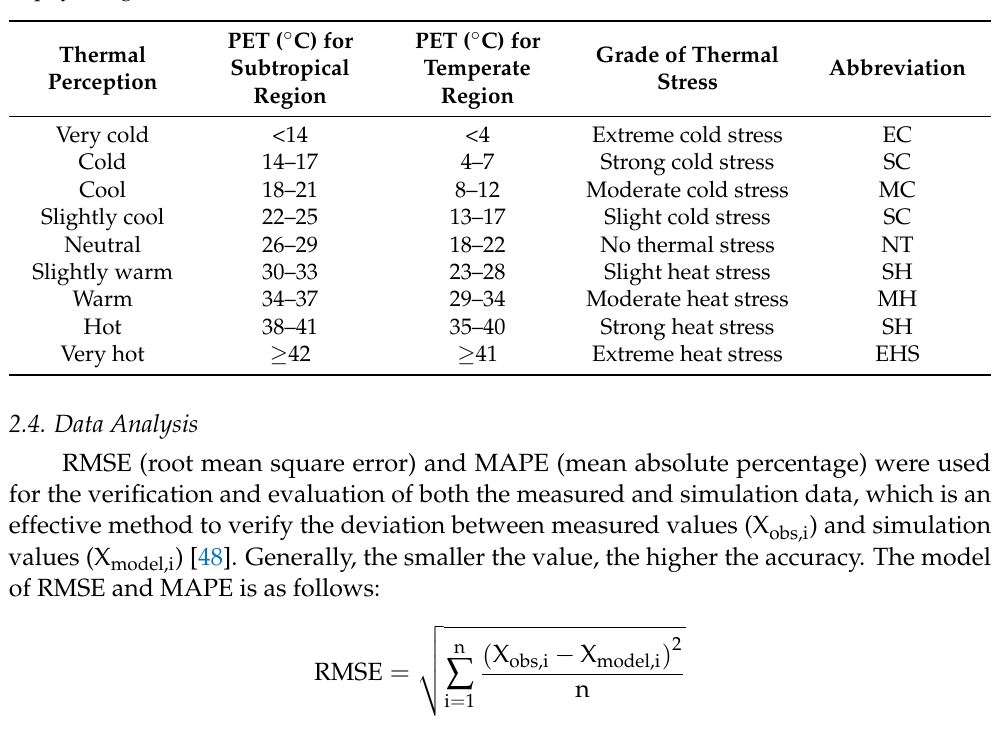
Table 3. The relationship between physiological equivalent temperature (PET) range and the grade of physiological stress